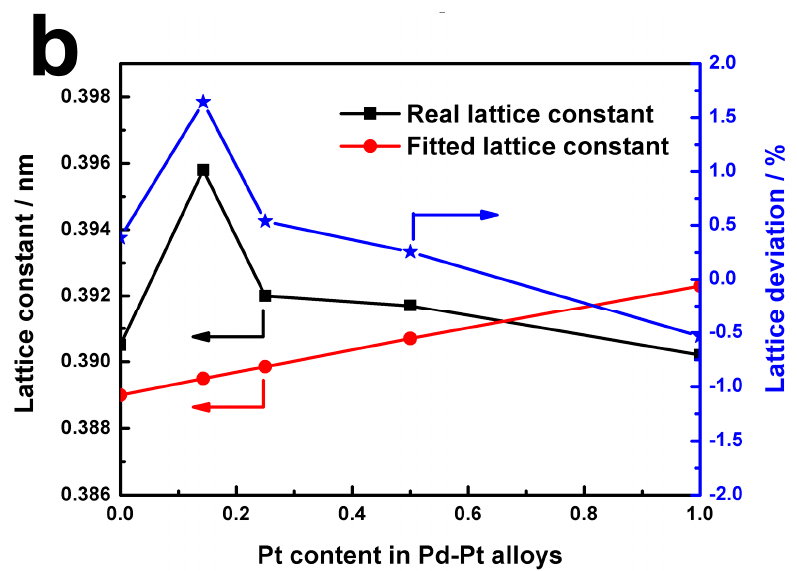
Figure 5. ( a ) XRD patterns of the Pd/rGO3500-1, Pd-Pt/rGO3500-1 with different Pd/Pt ratios and Pt/rGO3500-1 samples; ( b ) actual lattice constant and fitted lattice constant based on Vegard’s law, as well as the deviation between the actual and fitted data.